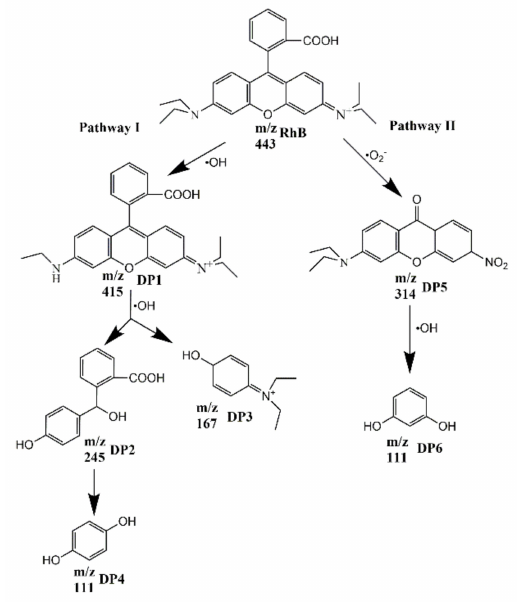
Figure 10. The possible photodegradation pathways of